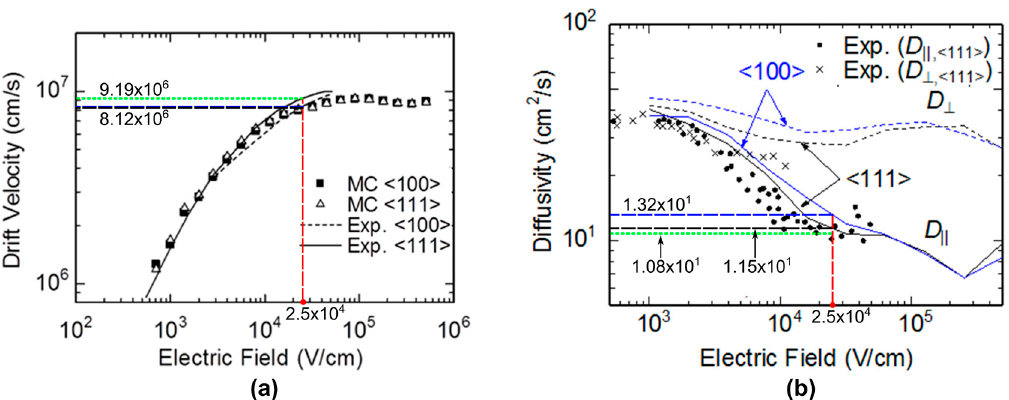
Figure 7. ( a ) Drift velocity with respect to electric field at 300 K [31,32]; ( b ) diffusivity with respect to electric field at 300 K [31,33].